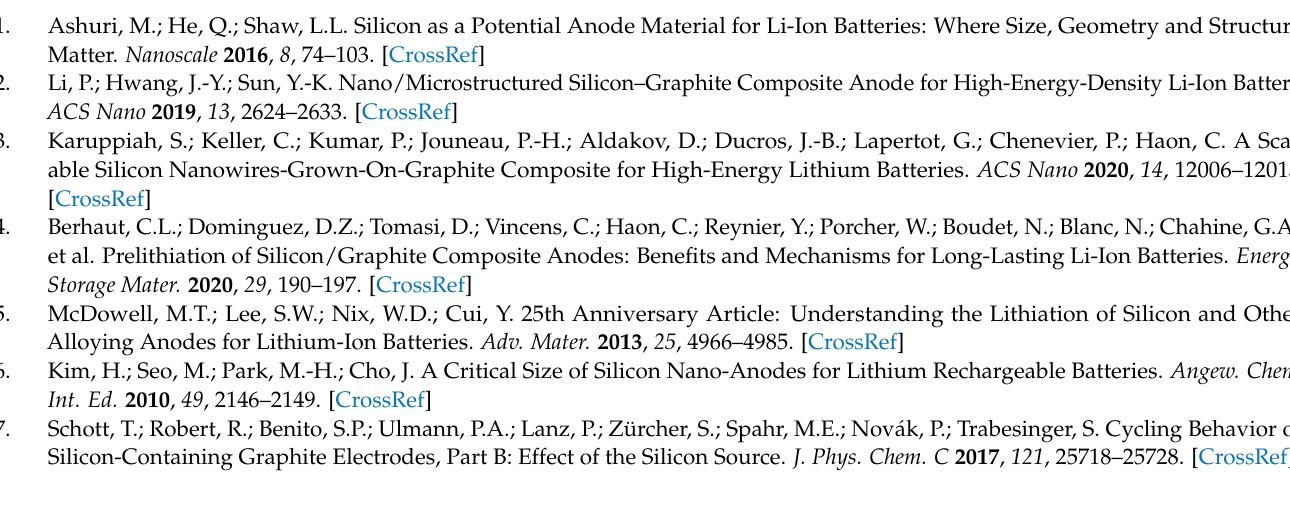
Figure S3 SEM images of AuNPs and SiNWs; Figure S4: SEM images/diameters of SiNWs grown from 12 nm AuNPs on CaCO 3 nanopowder or in carbon foam cube; Figure S5: Specific capacity and coulombic efficiency for all SiNPs; Figure S6: SEM image of an electrode with SiNW 9 ; Figure S7: Specific capacity in the galvanostatic/potentiostatic steps; Figure S8: Cell potential vs. normalized galvanostatic